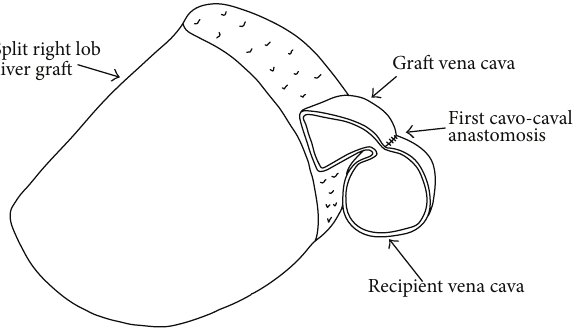
Figure 1: The caudate lobe was resected.